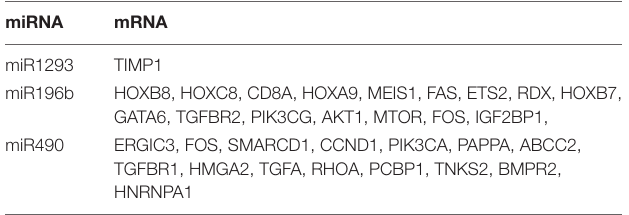
TABLE 3 | The miRTarBase database revealed interactions between miRNA and